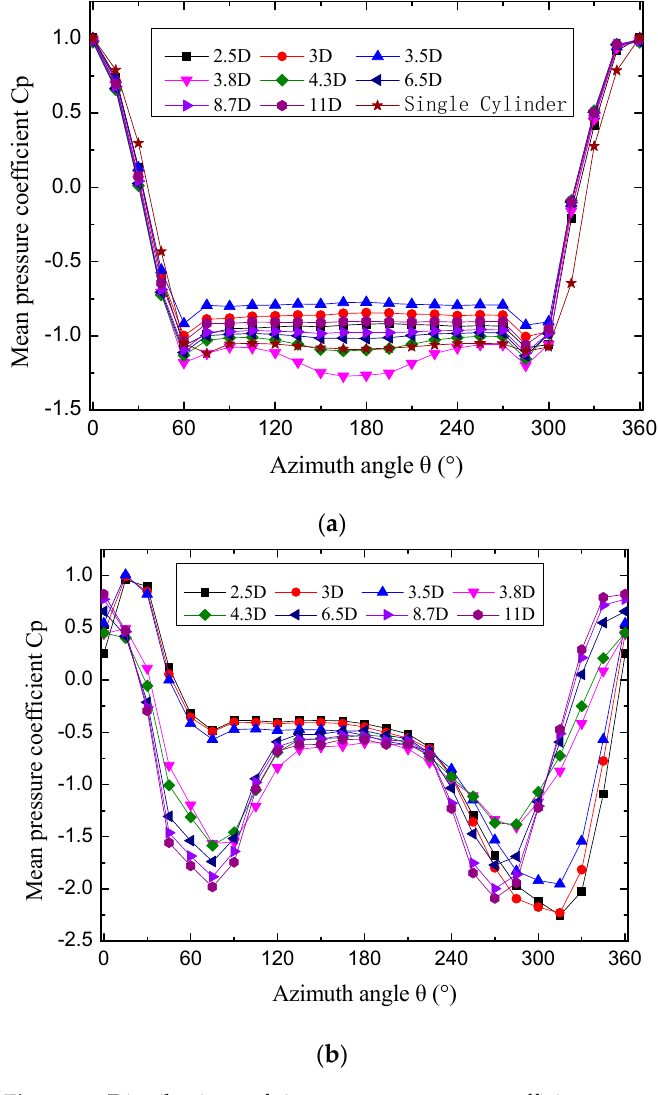
Figure 5. Distributions of time–mean pressure coefficients on cylinders at α = 9°: ( a ) upstream cylinder; ( b ) downstream cylinder.